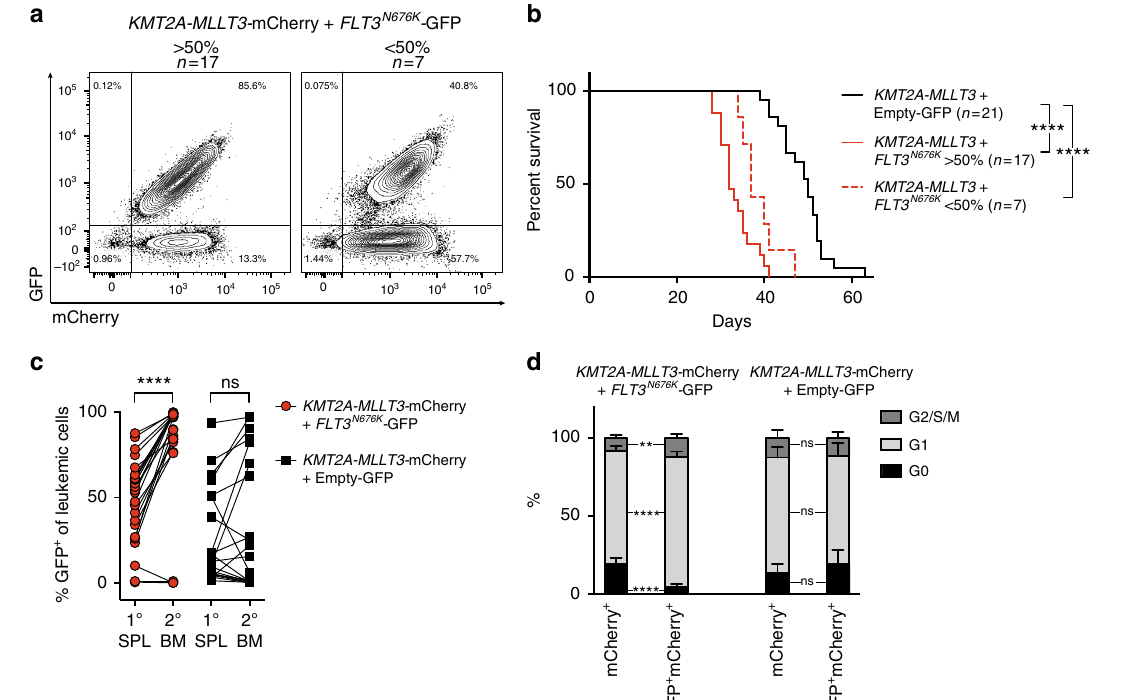
R ALL, a majority of the kinase/PI3K/RAS-pathway mutations are present in subclones 4,5 , raising the possibility that cells with